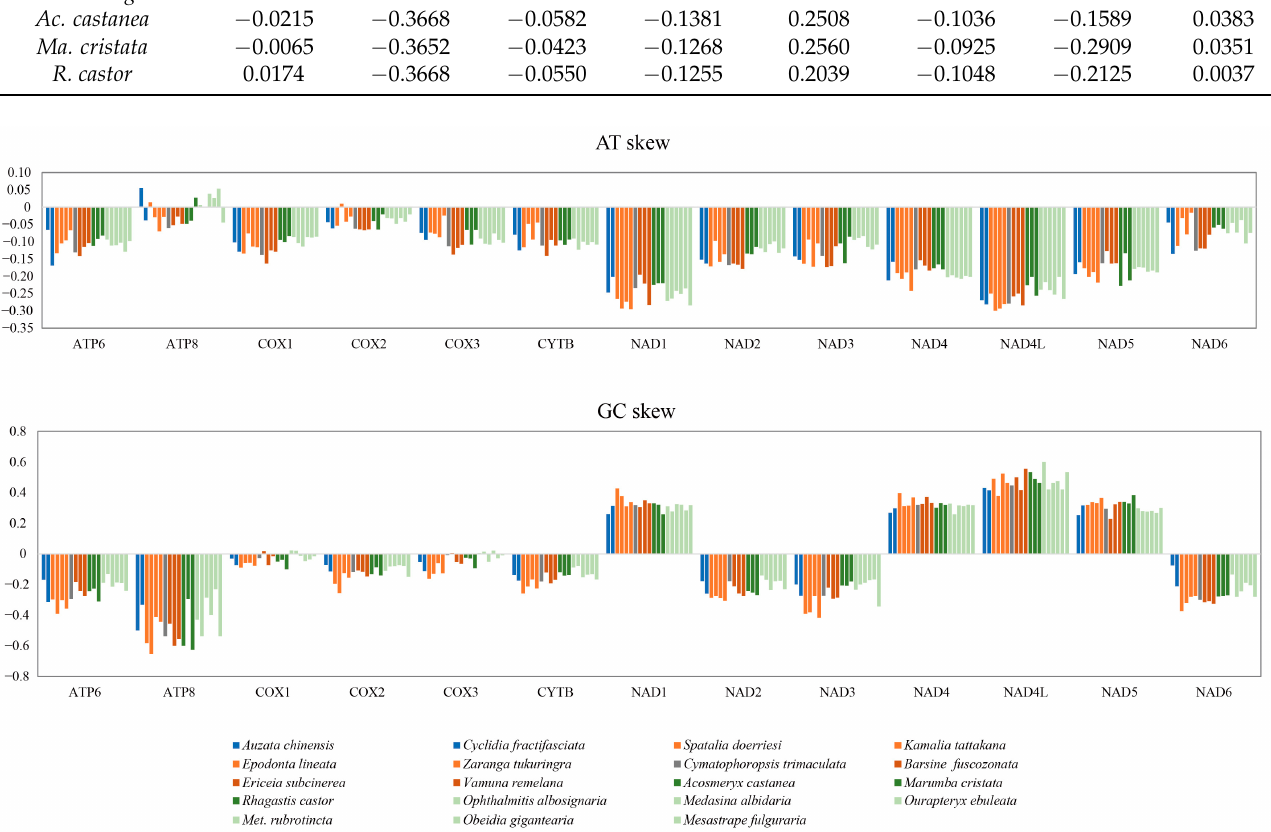
Table 2. AT and GC skew at different position of codon for 13 PCG genes in 19 moth mitogenomes.